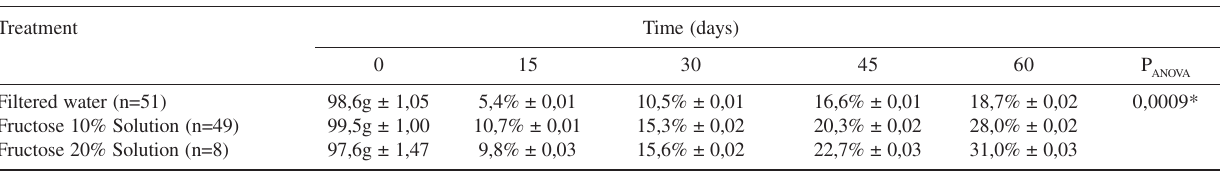
Table 1 - Variation of body weight (g) in animals treated for 2 months with filtered water, 10%, or 20% fructose solution and the standard laboratory diet. Results are expressed as mean ±